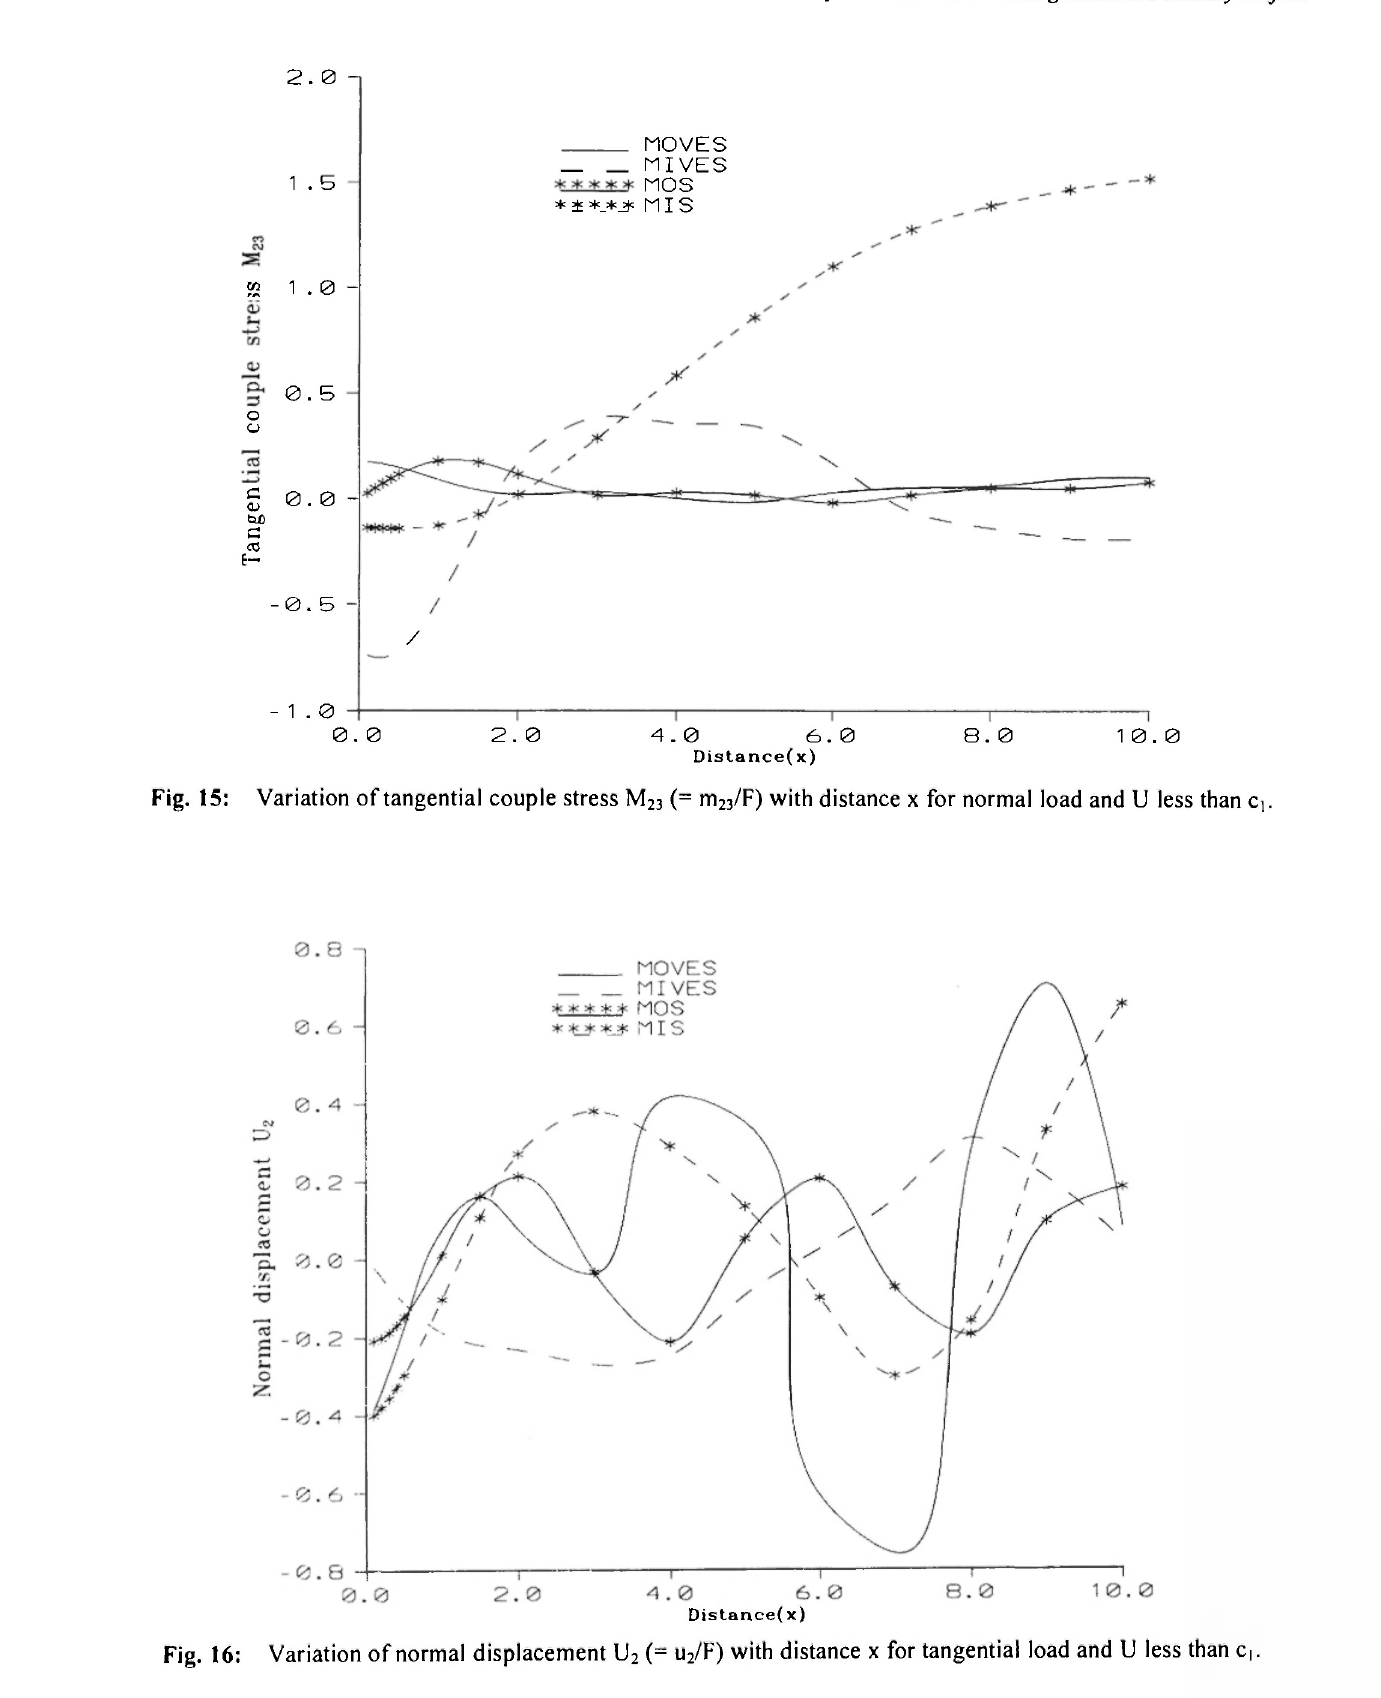
Fig. 16: Variation of normal displacement U 2 (= u 2 /F) with distance χ for tangential load and U less than